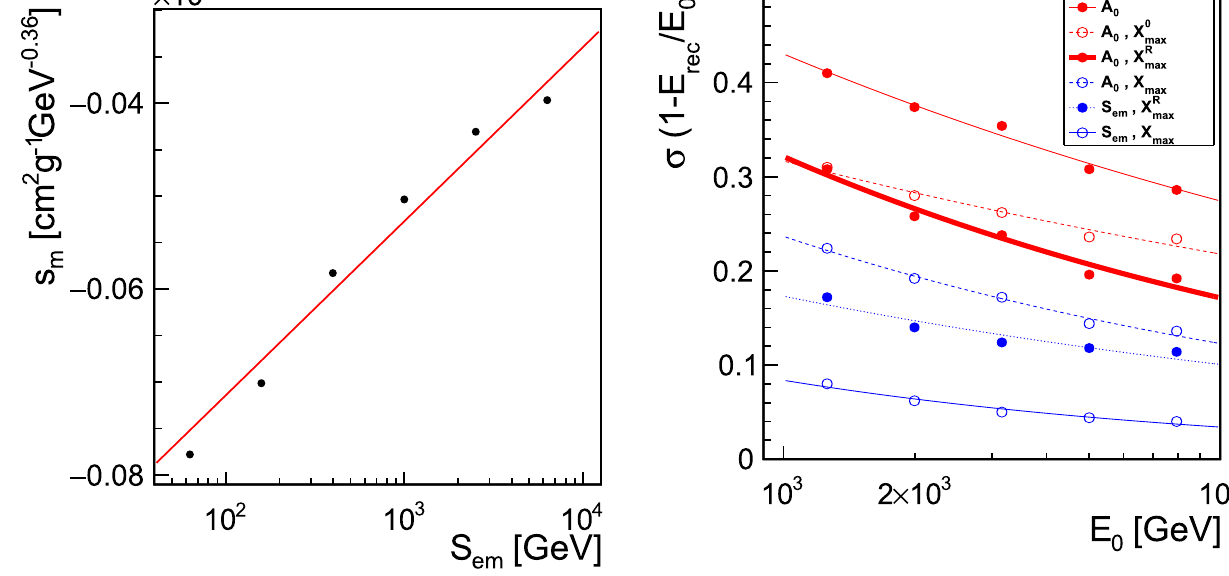
Fig. 15 Energy resolution as a function of the primary energy. The red lines correspond to constant C coefficients (thin) and C ( X max , f 20 ) coefficients, using X R max (thick) or X 0 max (dashed); resolutions obtained with simulated values are also shown for comparison (blue lines): sim- ulated value of X max (dashed), simulated value of S em (pointed) and both simulated values (thin) blue line) or finally using both simulated values (blue thin